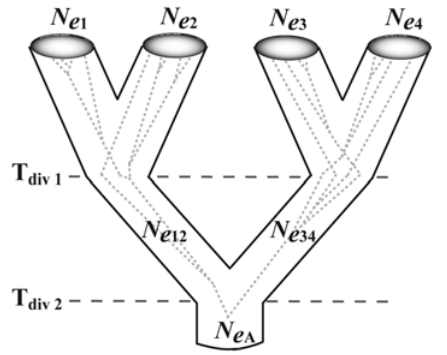
Figure 4. Hypothetical population tree containing a gene tree (dashed lines) that has been simulated via neutral coalescence. Even this relatively simple four-population model with zero post-divergence gene flow has many parameters that must be specified during construction of the population tree. Here, these include N ancestral populations, two successive splitting times (T population tree branch lengths are measured in organismal generations (scale not